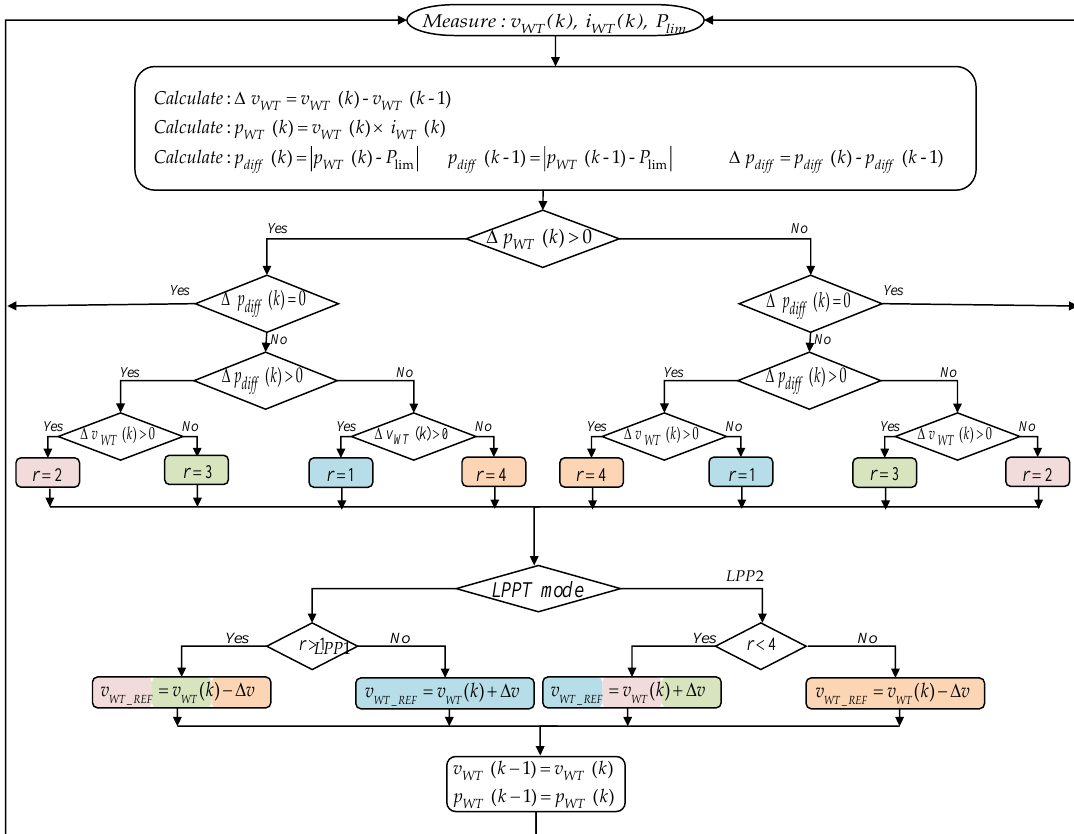
Figure 6. Principle of perturb and observe (P&O) method for limited power point tracking (LPPT) mode.